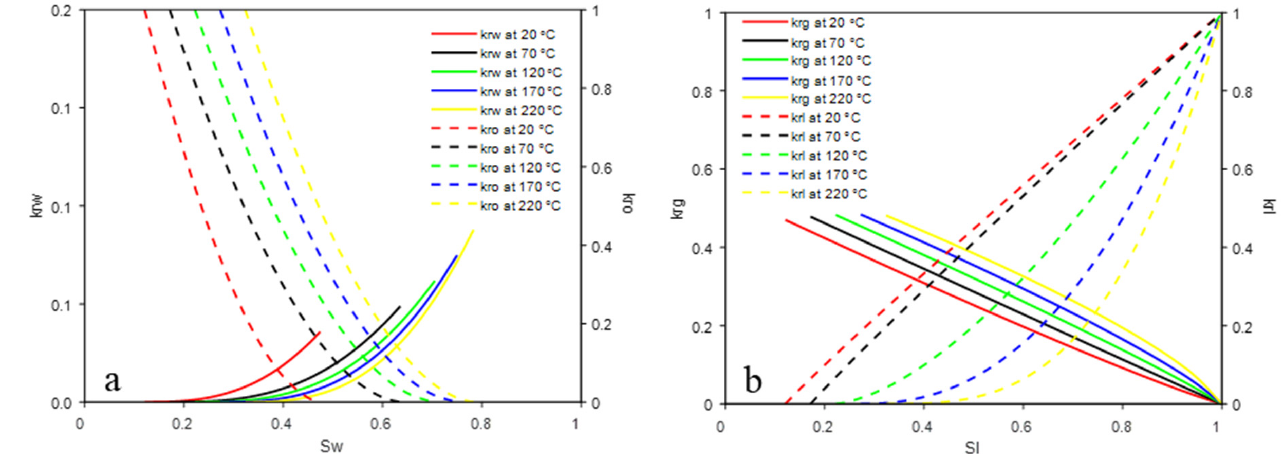
Figure 3. Temperature-dependent relative permeabilities of the Athabasca oil sands: ( a ) oil–water relative permeability curves and ( b ) liquid–gas relative permeability curves.